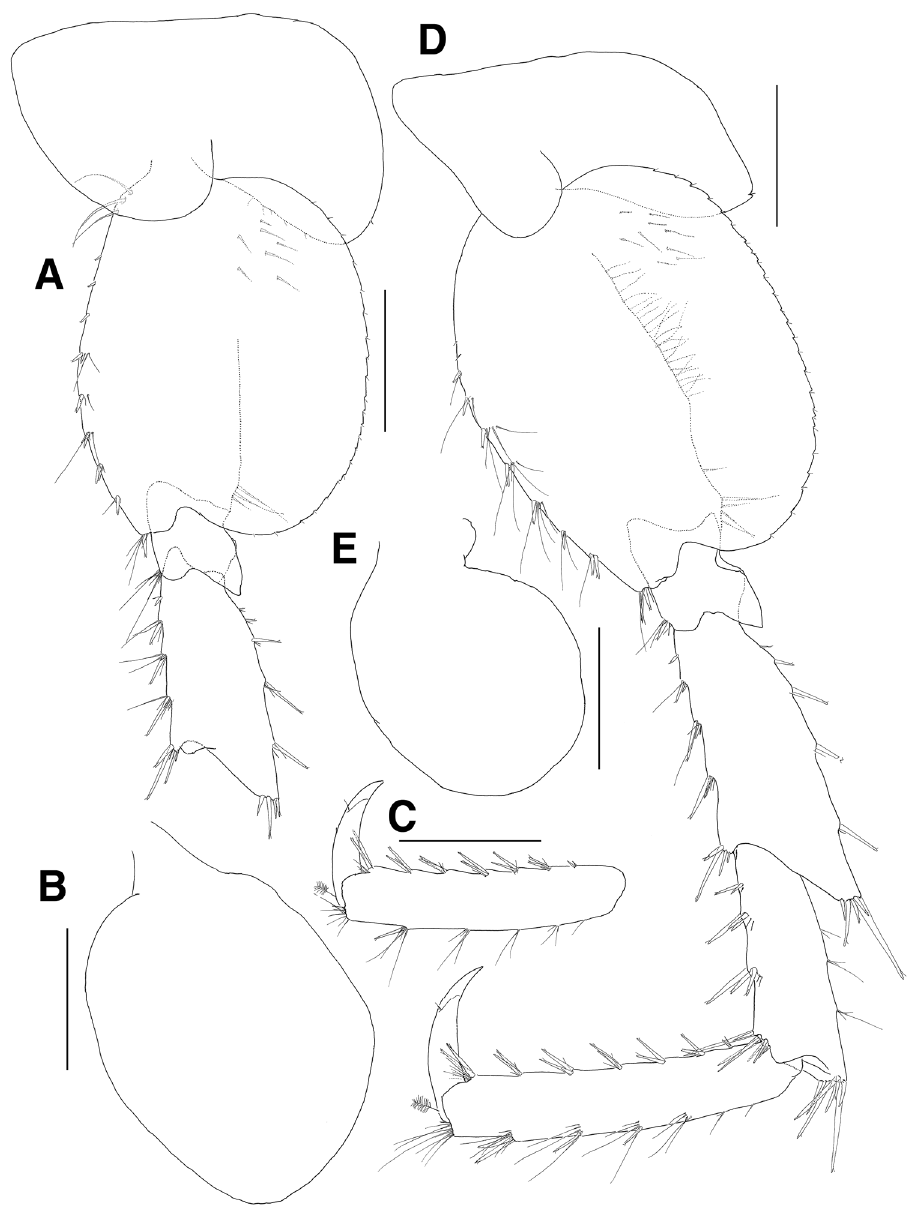
Figure 4. Eusiroides pilopalpus sp. n., holotype. A Pereopod 5 B Coxal gill of pereopod 5 C Propodus and dactylus on pereopod 5 D Pereopod 6. Scale bars 0.5